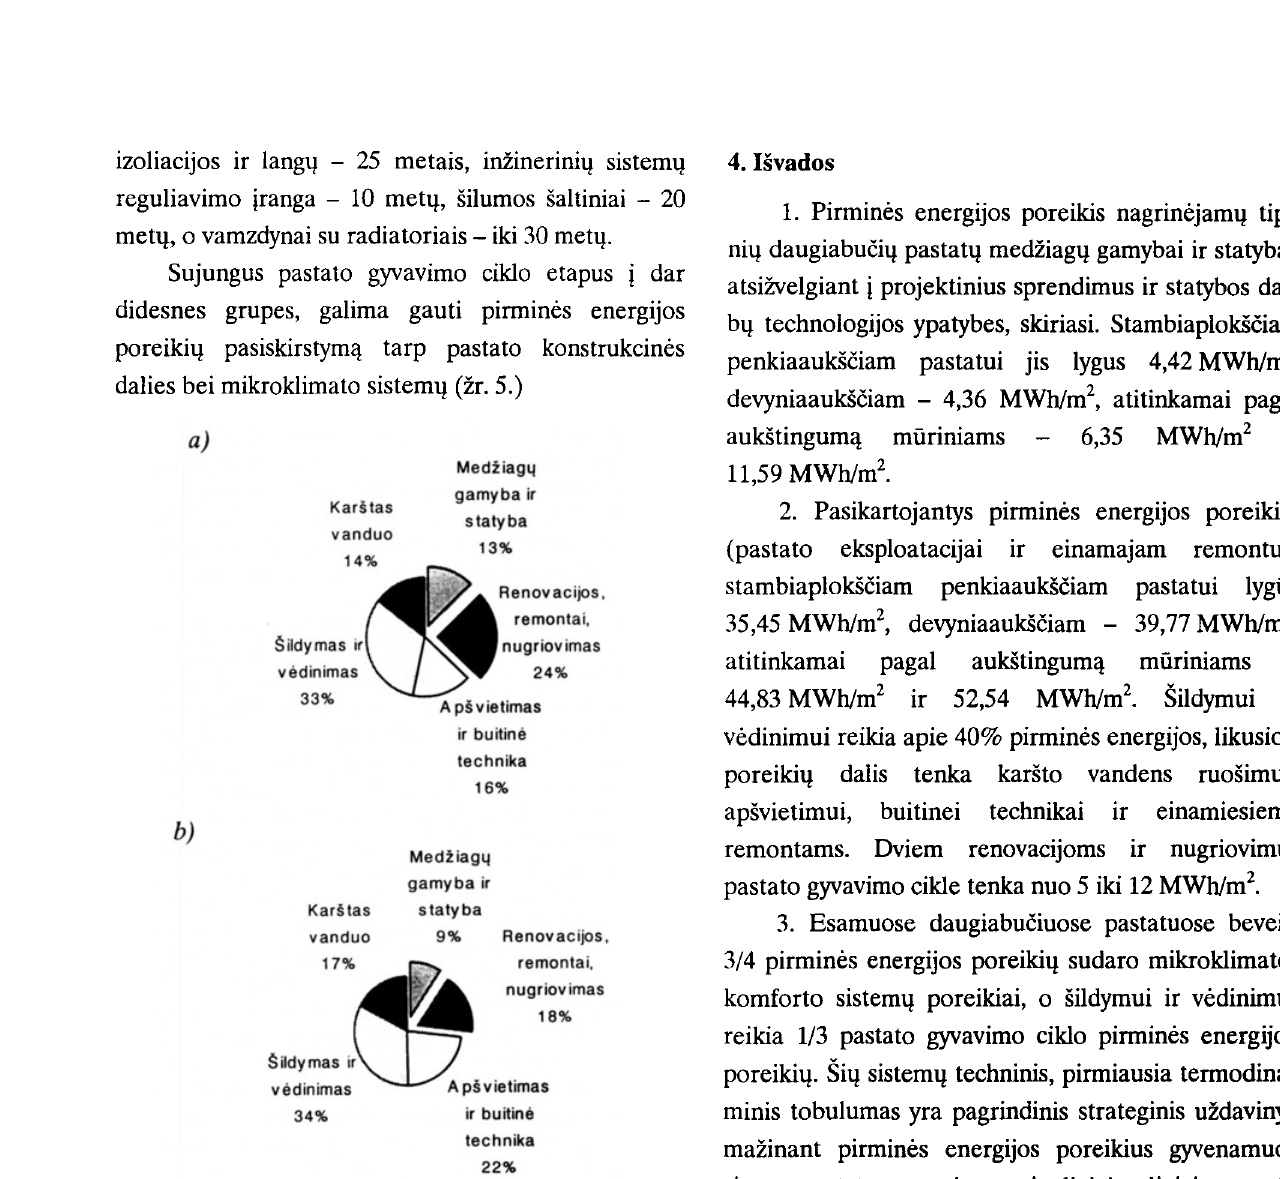
pastatams; b) plytiniarns pasta tams Fig 5. Distribution of primary energy demands of b~il~ing life cycle of dwelling houses: a) concrete panel bmldmgs b) brick